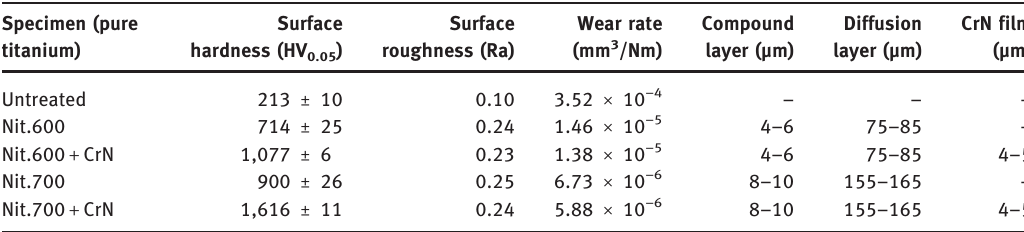
Table 2: The values of compound layer thickness, diffusion layer thickness, surface roughness, surface hardness, wear rate, and CrN film